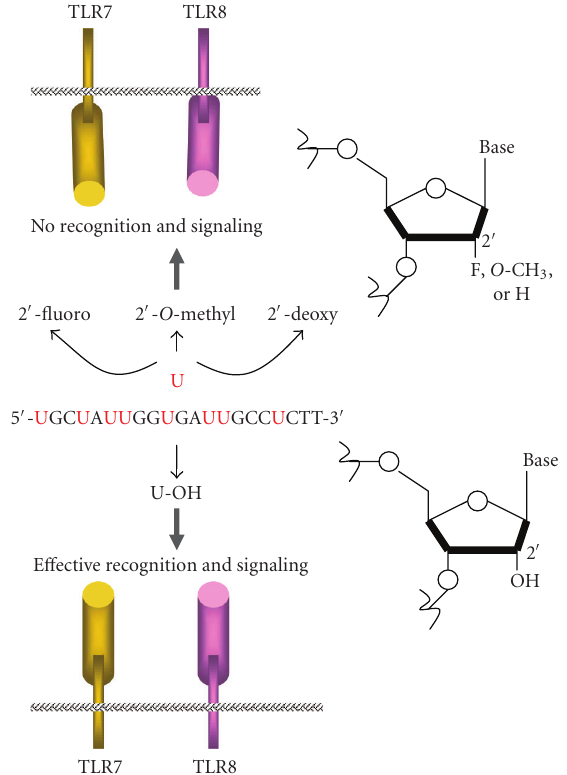
Figure 1: Unmodified siRNA duplexes and single-stranded siR- NAs (sense or antisense strand) activate innate immunity through TLR7 and TLR8 resulting in cytokines and type I interferon produc- tion. 2 (cid:2) -ribose modifications of uridines abrogate TLR recognition of RNAs and therefore signaling [21]. Modified ss siRNAs did not compete with unmodified siRNAs to activate TLR signaling, indi- cating that 2 (cid:2) modifications of uridines block the binding to TLRs (unpublished